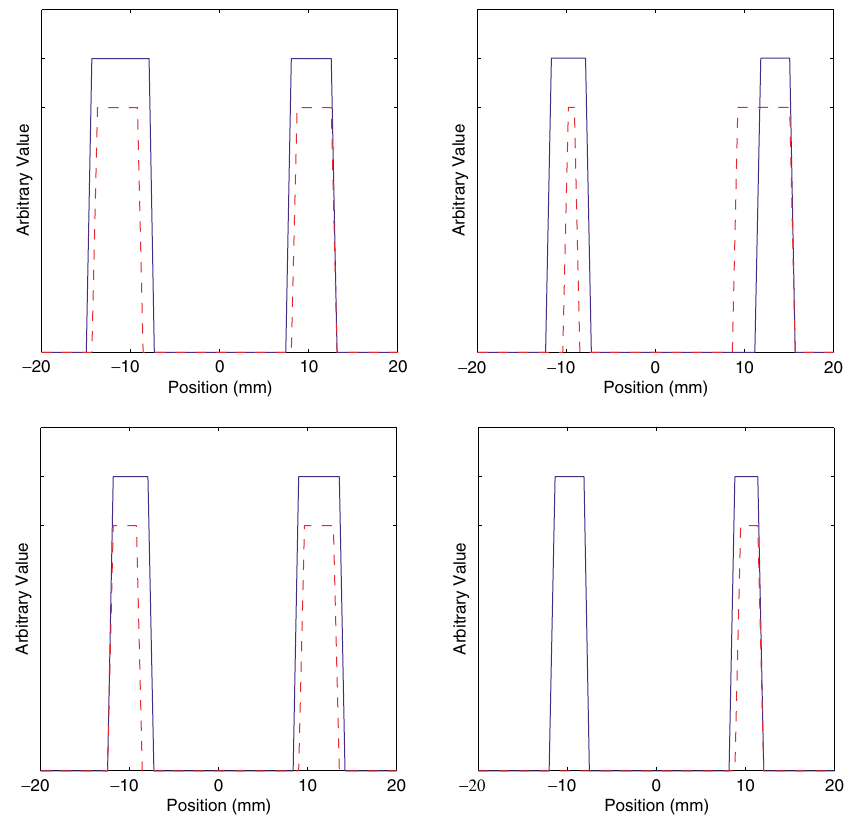
FIG. 21. (Color) Random scans along diameters of each end cap. The solid lines correspond to regions of surface roughening and the dotted lines are for regions that contain cracks on the surface. The centers of the end caps are at position 0